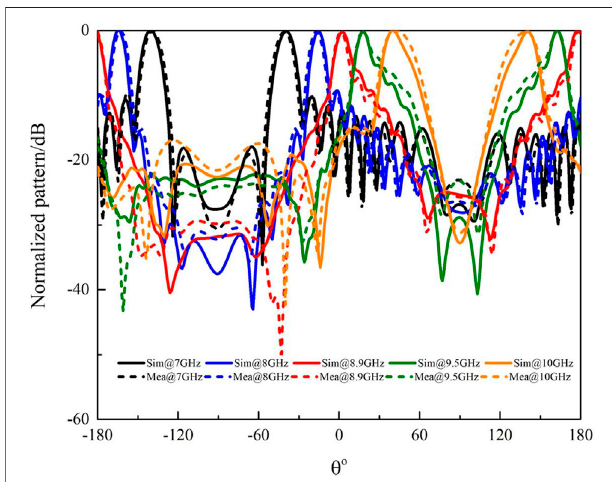
FIGURE 9 | Simulated and measured normalized pattern at different frequencies.